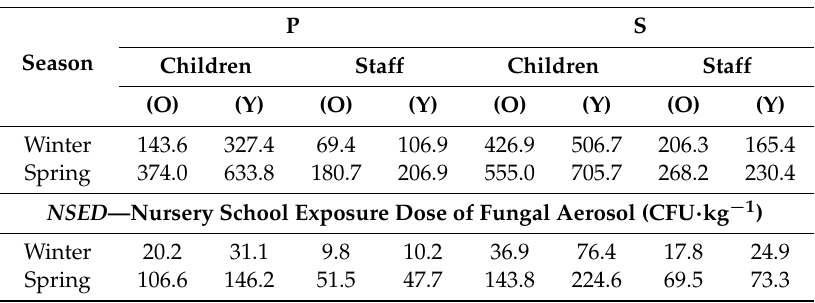
Table 4. Calculated exposure dose (NSED) of bacterial and fungal aerosols inhaled by younger (Y) and older (O) children, as well as by nursery school